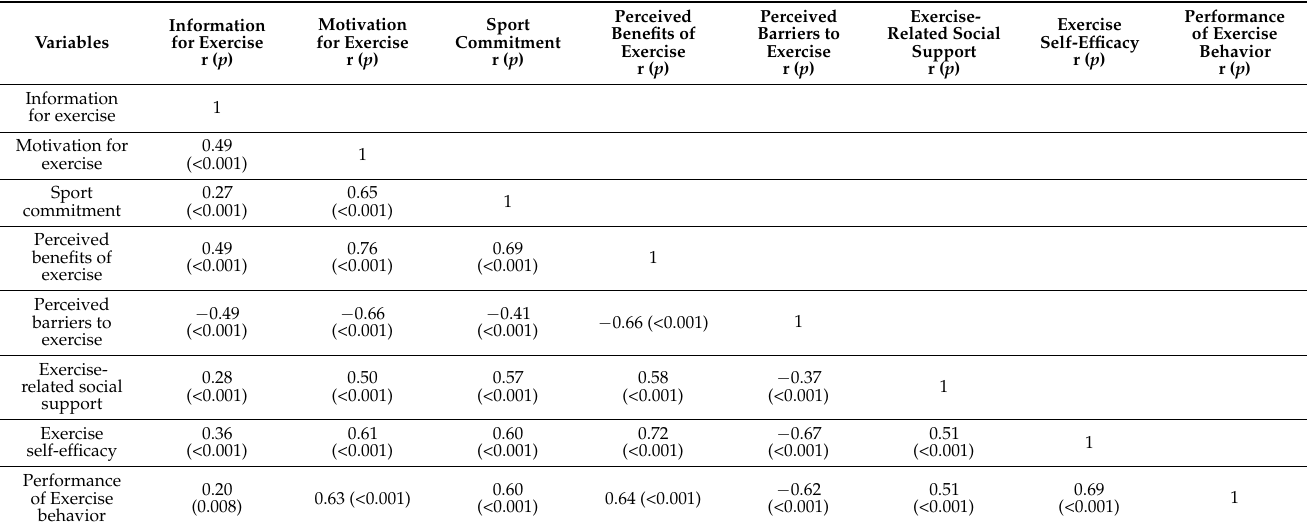
Table 3. Relationships of information for exercise, motivation for exercise, sport commitment, perceived benefits of exercise, perceived barriers of exercise, exercise-related social support, exercise self-efficacy, and performance of exercise